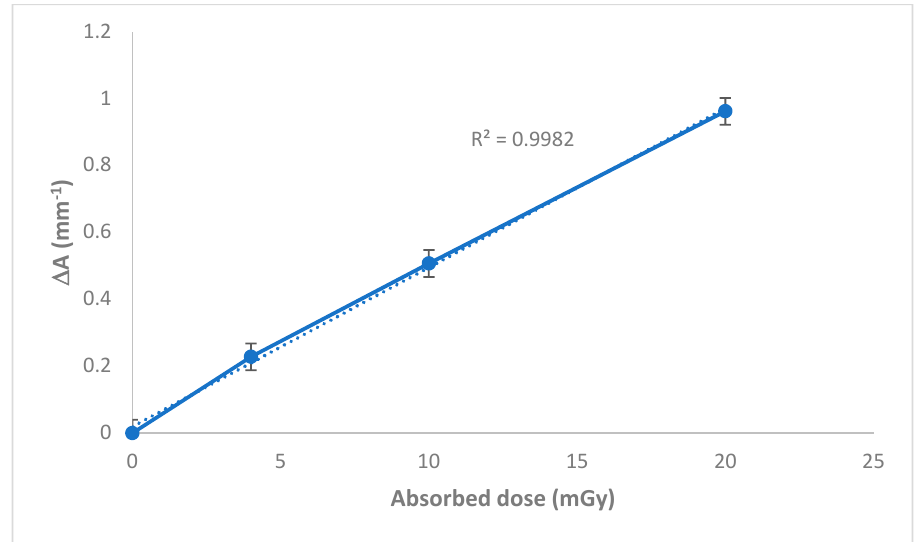
Figure 4. Dose–response curve based on UV-Vis absorption capacities at λ max for PVA/NBT films exposed at various X-ray doses.